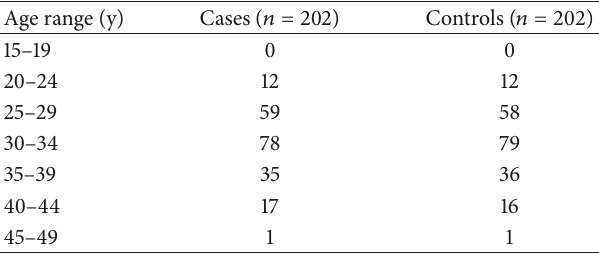
Table 1: Distribution of age across cases and